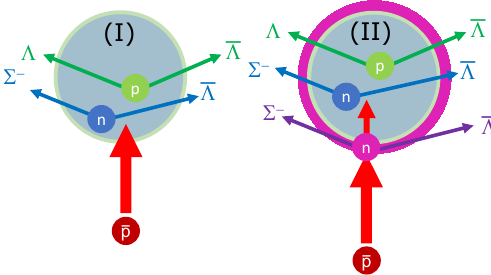
Figure 1. Illustration of ΛΛ and Σ − Λ pair production in antiproton–nucleus interactions close to their thresholds. At low energies, ΛΛ pairs are produced in p + p collisions, while Σ − Λ pairs can only be produced in p + n interactions. We consider two isotopes (I) and (II) which di ff er by an additional outer neutron layer with thickness ∆ n , indicated in